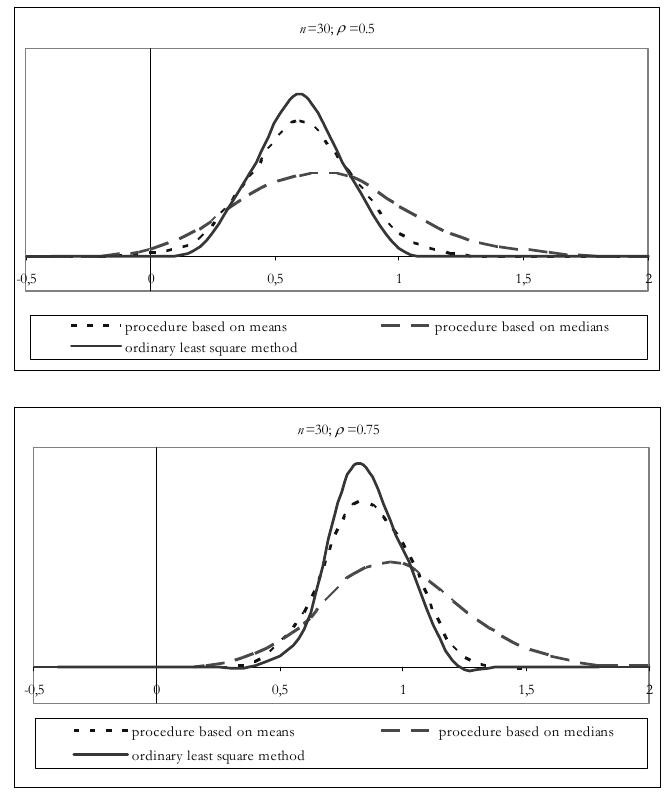
ˆ a for N = 1000, n = 20 and  = 0.5 and 11